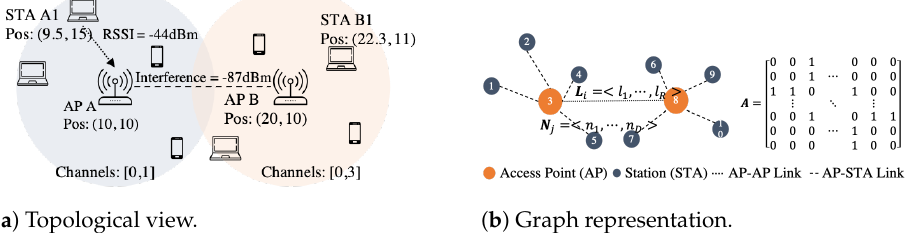
Figure 2. Example of a WLAN deployment. On the left, the topological view of the deployment, some measurements are included. On the right, the graph representation of the deployment with a node feature N j , an edge feature L i and its adjacency matrix A